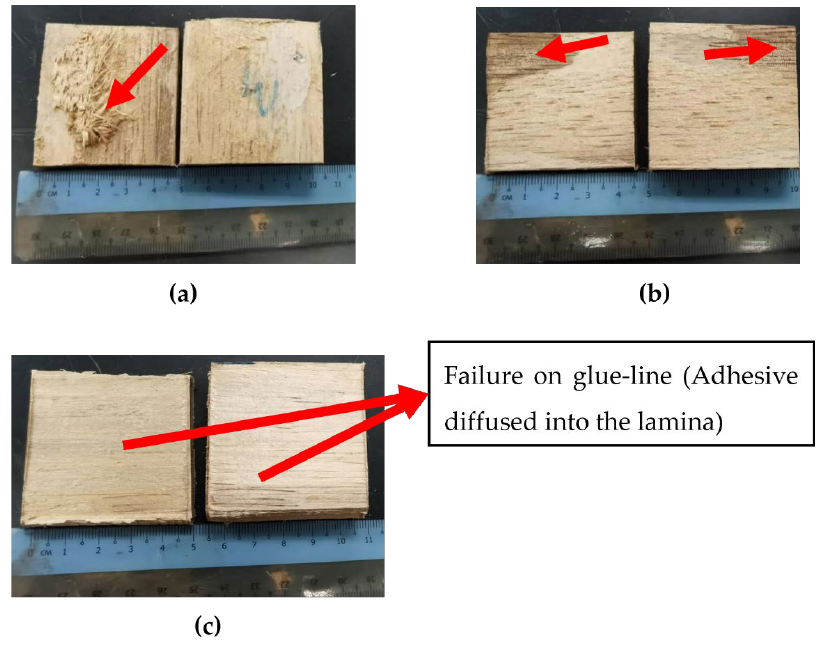
Forests 2022 , 13 , x FOR PEER REVIEW Figure 6. Failure on shear; (a) glue–glue interface, (b) wood–glue interface, and (c) wood–wood Figure 6. Failure on shear; ( a ) glue–glue interface, ( b ) wood–glue interface, and ( c ) wood–wood interface. interface.